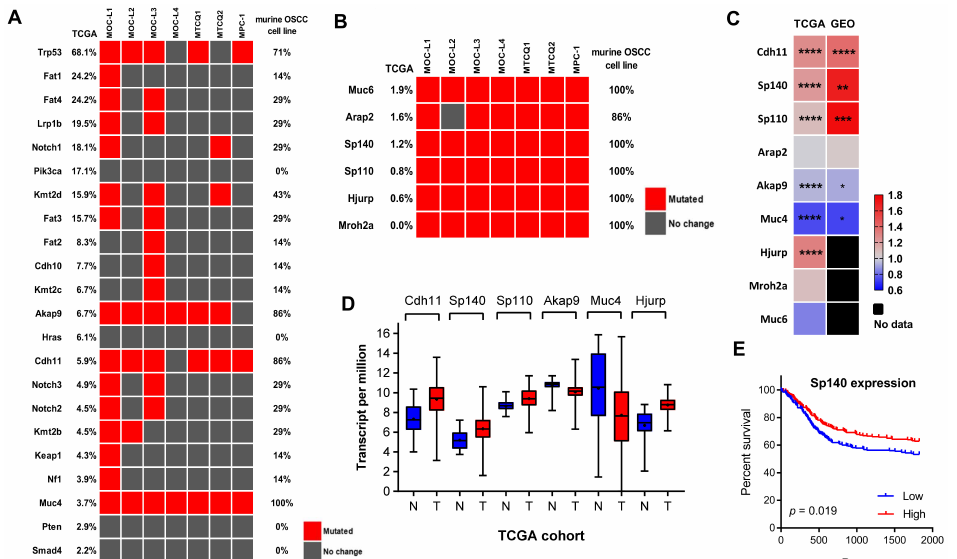
Figure 5. Gene mutations in murine OSCC cells. ( A , B ) Heatmap of the mutations present in the various murine OSCC cell lines. ( A ) Analysis according to the order of mutation frequency using the TCGA dataset. ( B ) Analysis according to the presence of mutations in nearly all murine OSCC cells. ( A , B ) Left, the mutation frequency based on the TCGA dataset. Right, the mutation frequency in murine OSCC cell lines. A red block indicates the mutated gene. ( C ) Heatmap of gene expression levels in the TCGA and GEO datasets. Right, gradient bar. * p < 0.05; ** p < 0.01; *** p < 0.001; **** p < 0.0001. ( D ) Whiskers and a box diagram illustrating the expression levels of genes based on the TCGA human HNSCC